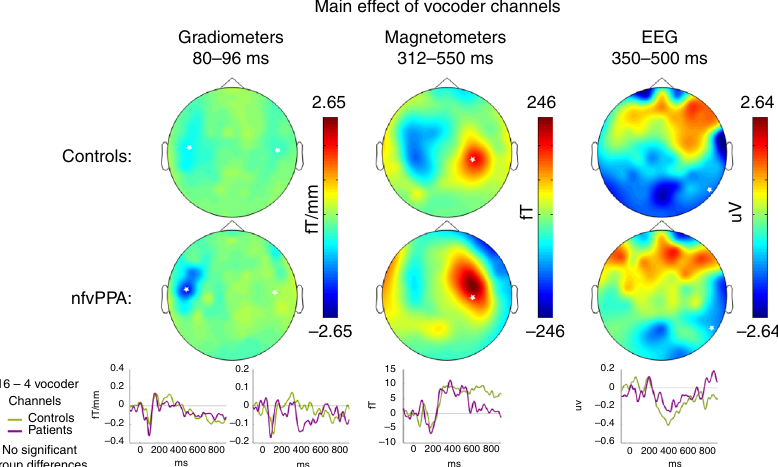
Fig. 3 The effect of vocoder channel number. Illustrative topographic plots are shown of the main effect of vocoder channels across all participants. No group by sensory detail interactions were observed either at the peak locations (marked by white stars) or in a con fi rmatory